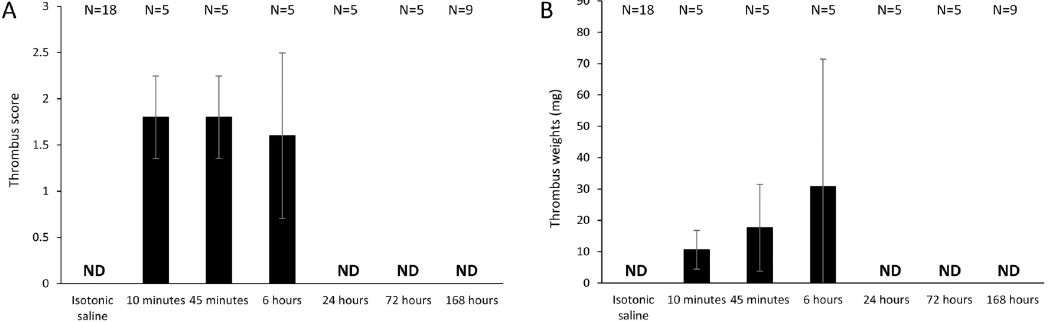
Fig 3. Time course of response to 4F-PCC. (A) thrombus score; (B) thrombus weight. ND, not detectable. Data for venous stasis- induced thrombosis at the indicated timepoints after the end of 4F-PCC (300 IU/kg) infusion. Figure shows mean (standard